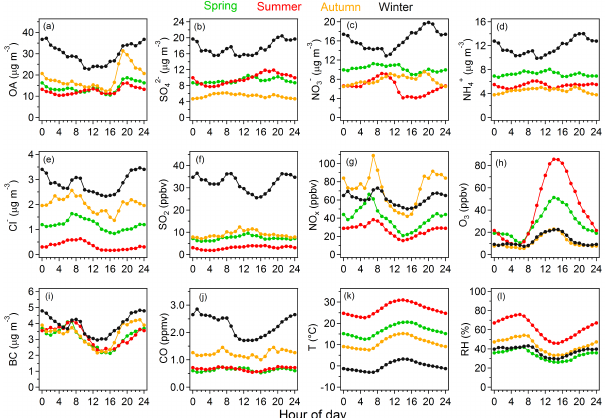
Figure 3. Diurnal patterns of chemical species of PM 1 , gaseous pollutants, temperature ( T ), and relative humidity (RH) during sea- sonal observations. The ranges of diurnal variations for each season are shown in Figs.